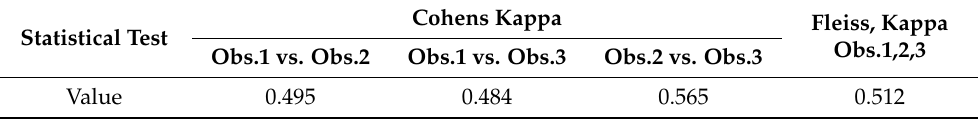
Table 3. Interobserver concordance for CDG evaluation.